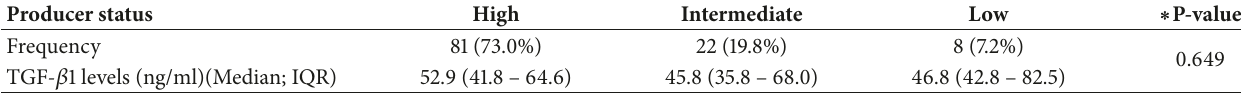
Table 6: Producer status and transforming growth factor- 𝛽 1 in genotyped study participants (n=111).